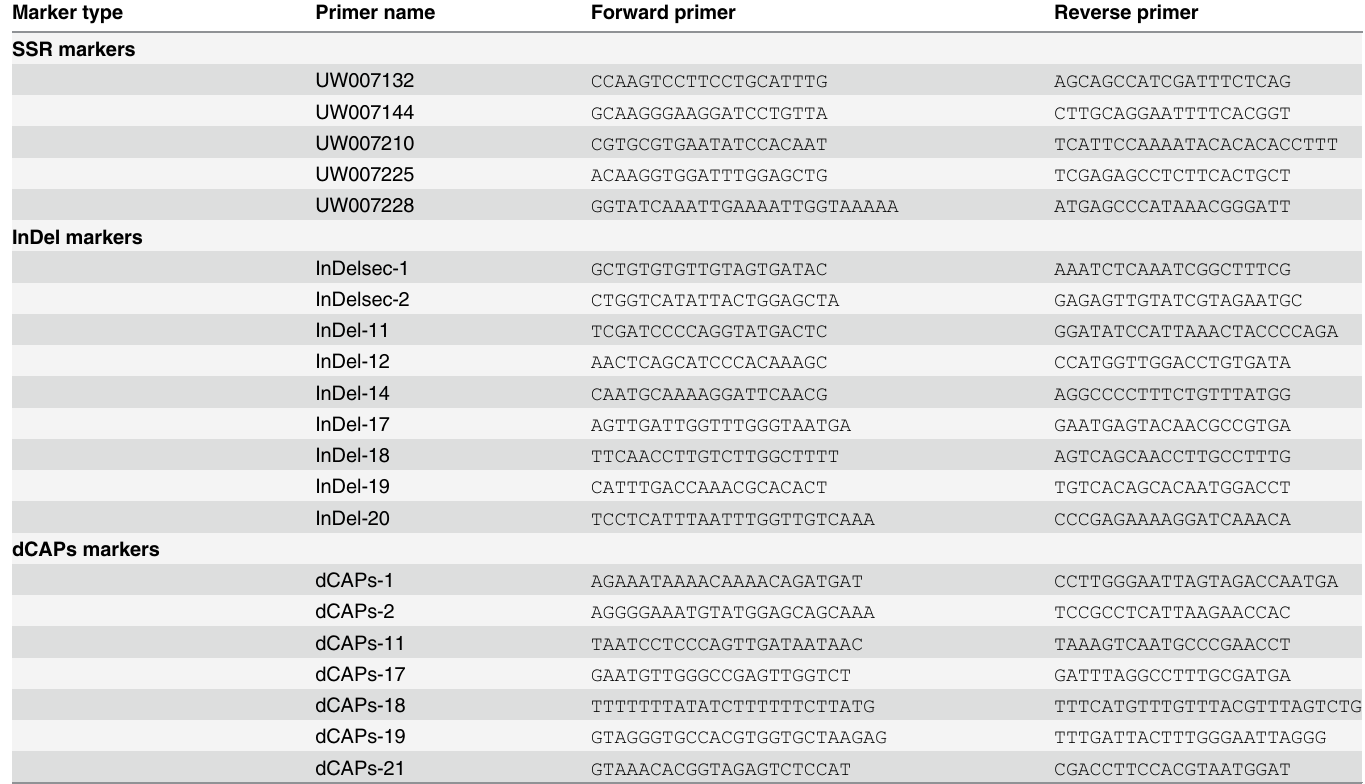
Table 2. The sequences of SSR, InDel and dCAPs primers used to produce the genetic linkage map of the putative csgl3